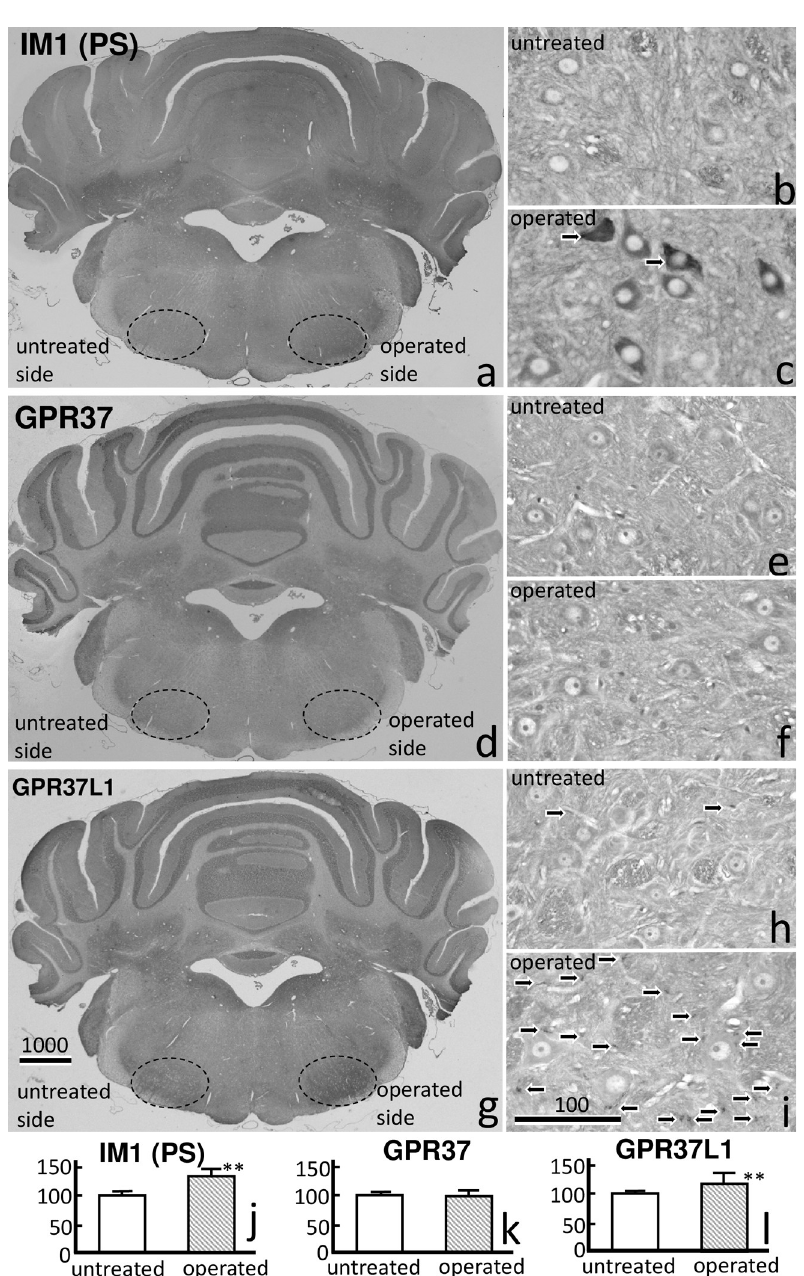
Fig 2. Prosaposin (PS:IM1), GPR37, and GPR37L1 immunoreactivity (IR) with DAB staining in facial nucleus 7 days after transection of the facial nerve. A) PS-IR clearly increased on the operated side. PS-IR was mainly observed in the motoneurons on the operated side (c) compared with those on the untreated side (b). d) GPR37-IR showed a weak increase on the operated side. e, f) A weak GPR37-IR signal was observed in the motoneurons on both sides. g) A strong GPR37L1-IR signal was observed around the motoneurons, predominately on the operated side. GPR37L1-IR was observed predominately in the glial cells (arrows) around the neurons on the operated side (i), and rarely on the untreated side (h). The numbers on the bars indicate the scale in microns. (j) PS-IR and (l) GPR37L1-IR were significantly higher on the operated side than on the untreated side (p �� < 0.01).